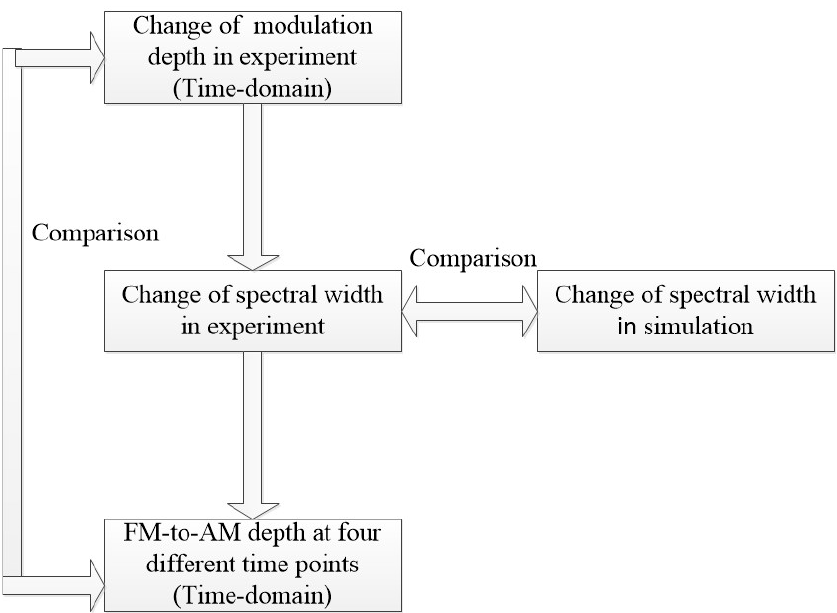
Figure 9. Chart of verification strategy.